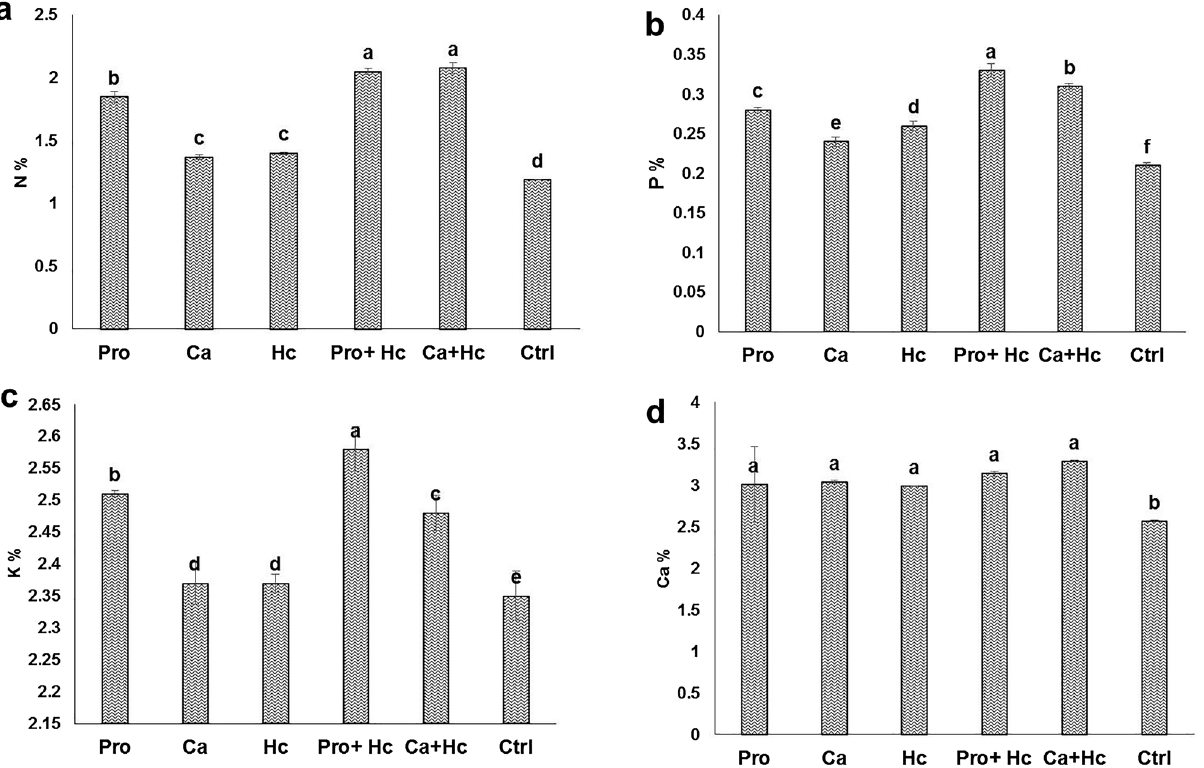
Figure 2. Effect of Proline (Pro) and Calcium (Ca) as foliar application alone or incombination with humic acid (Hc) as soil application on ( a ) nitrogen (N), ( b ) phosphorous (P), ( c ) potassium (K) and ( d ) calcium (Ca) leaves percent based on leaves dry weight of ‘Wonderful’ pomegranate trees grown under salt stress conditions. The different letters on the bars in each column represent significant difference at p ≤ 0.05; errors bars are standerd error of three replicates. Pro: 5 mM proline alone as foliar application; Ca: 1.5% calcium as foliar application alone; Hc: 15 g humic acid as soil application alone; Pro + Hc: 5 mM porline and 15 g humic acid; Ca + Hc: 1.5% calcium and 15 g humic; Ctrl: control (non